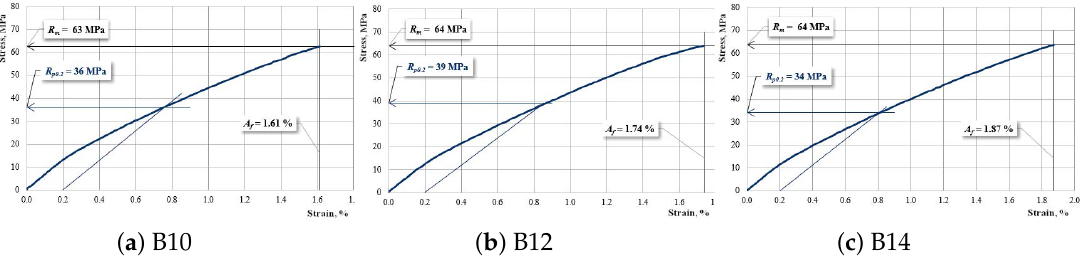
Figure 9. The characteristic curve for a sample: ( a ) B10; ( b ) B12; ( c ) B14.